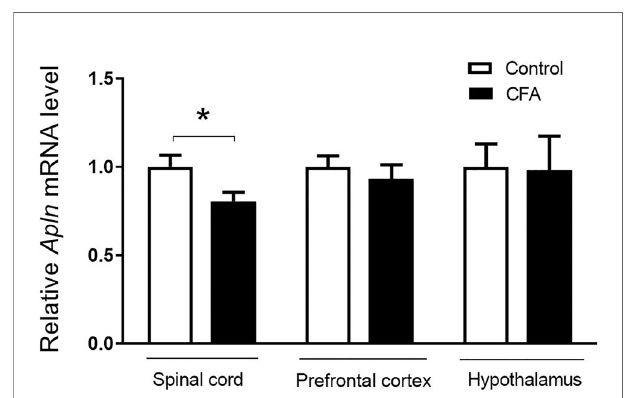
FIGURE 1 | Apln gene expression in the CFA-induced in fl ammatory pain in mice. mRNA levels in L4/5 spinal cord, prefrontal cortex and hypothalamus were detected by real-time qPCR, normalized with the housekeeping gene 36B4 . Data are expressed as means ± SEM. n = 8 or 9 per group. * p < 0.05, compared with